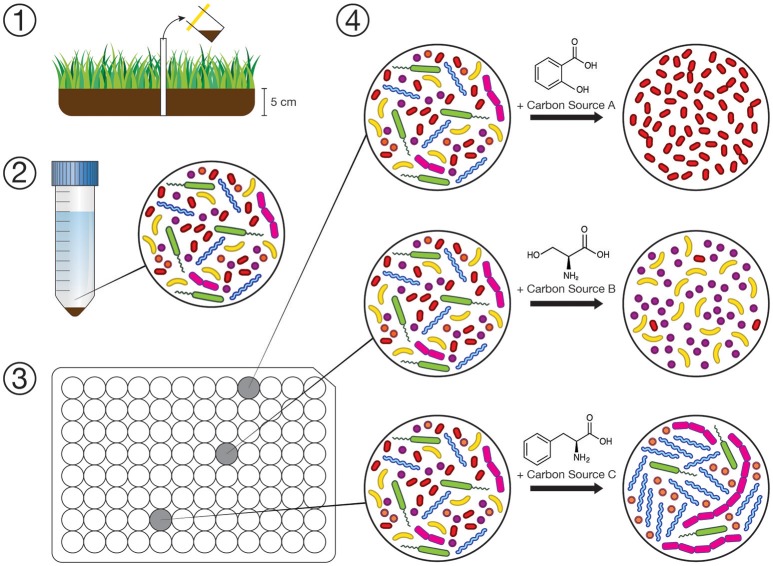
Conceptual diagram of our experimental workflow. (1) Collection of inocula for substrate arrays. (2) Dilute suspension of soil/water microbes prepared within 72 h. (3) Substrate arrays where each well is amended with one of 31 individual carbon sources (in triplicate), inoculated with suspension (1:100 m/v dilution), and incubated for 72 h. (4) Changes in composition of microbial communities in the substrate array is assayed by sequencing 16S rRNA gene amplicons on the Illumina MiSeq platform.